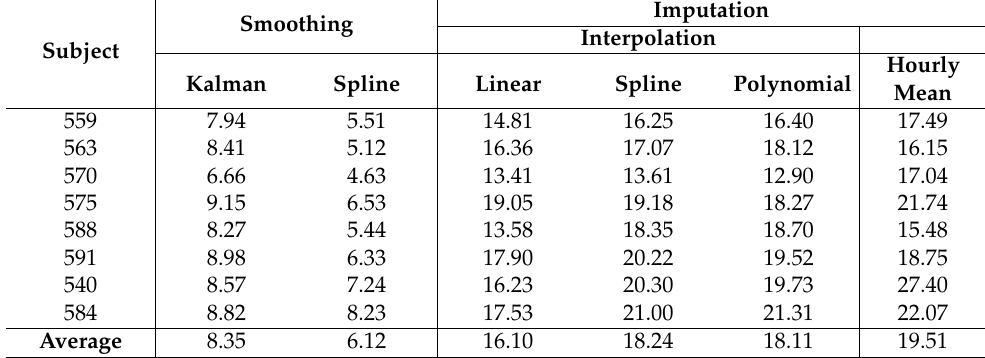
Table 5. Average RMSE for predicting glucose level using 1D-CNN after imputation/smoothing.